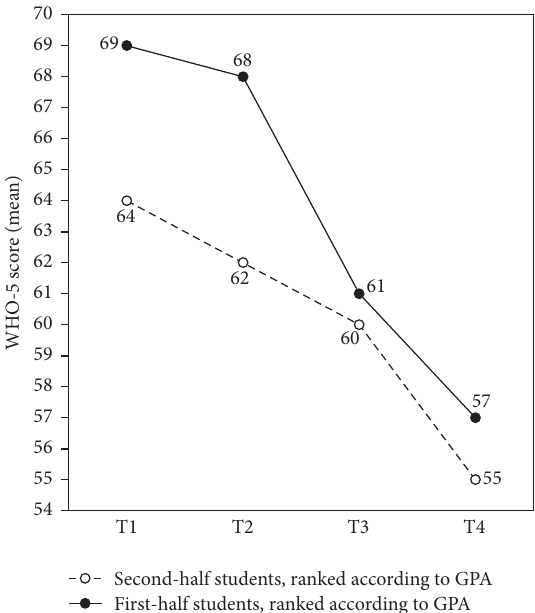
Figure 4: Subgroup analysis of the change of dental students’ positive well-being, according to their GPA related ranking.